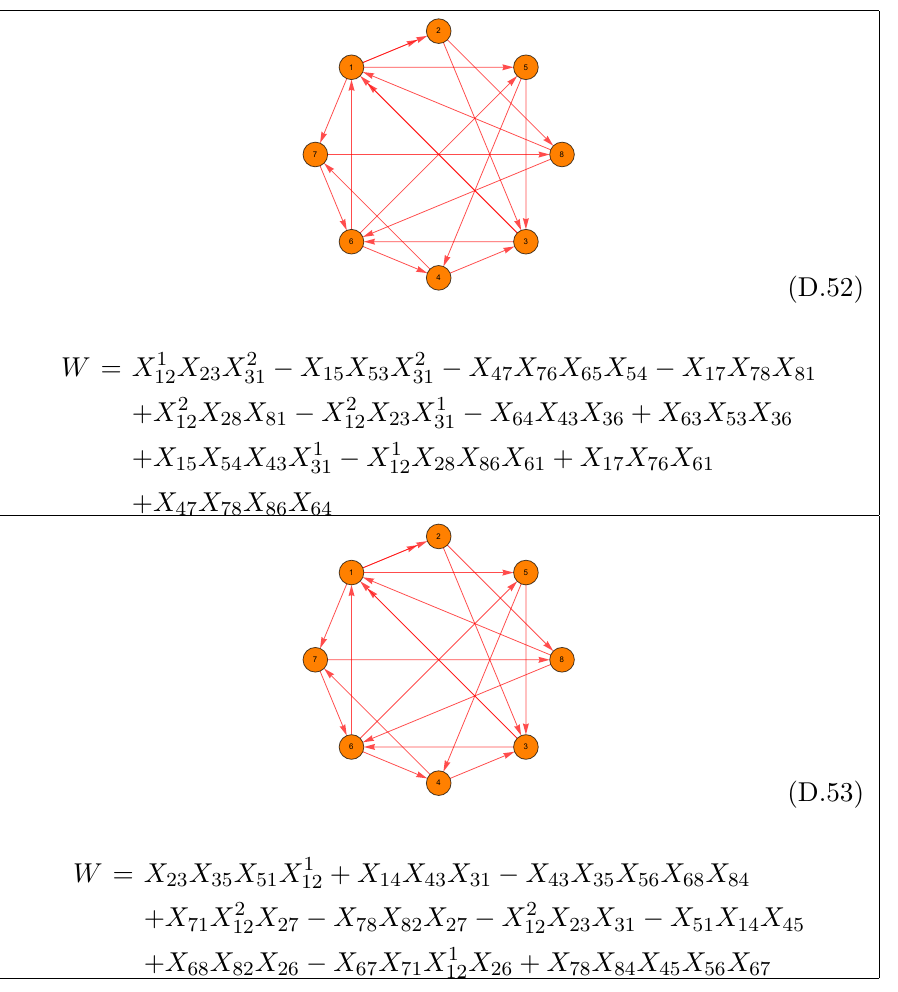
Table 7. The remaining toric phases of (5.22) in section